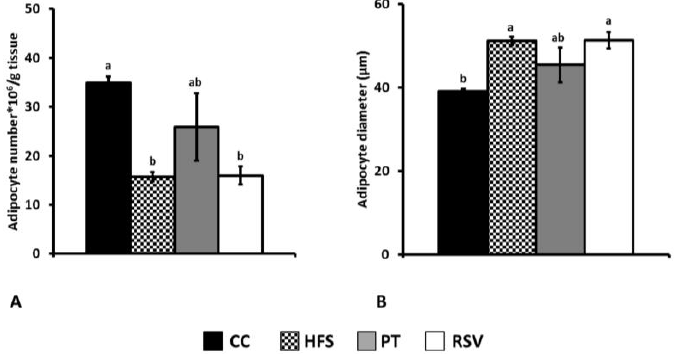
Figure 3. Adipocyte number ( A ) and size ( B ) in epididymal adipose tissue. Different letters indicate statistically significant differences.